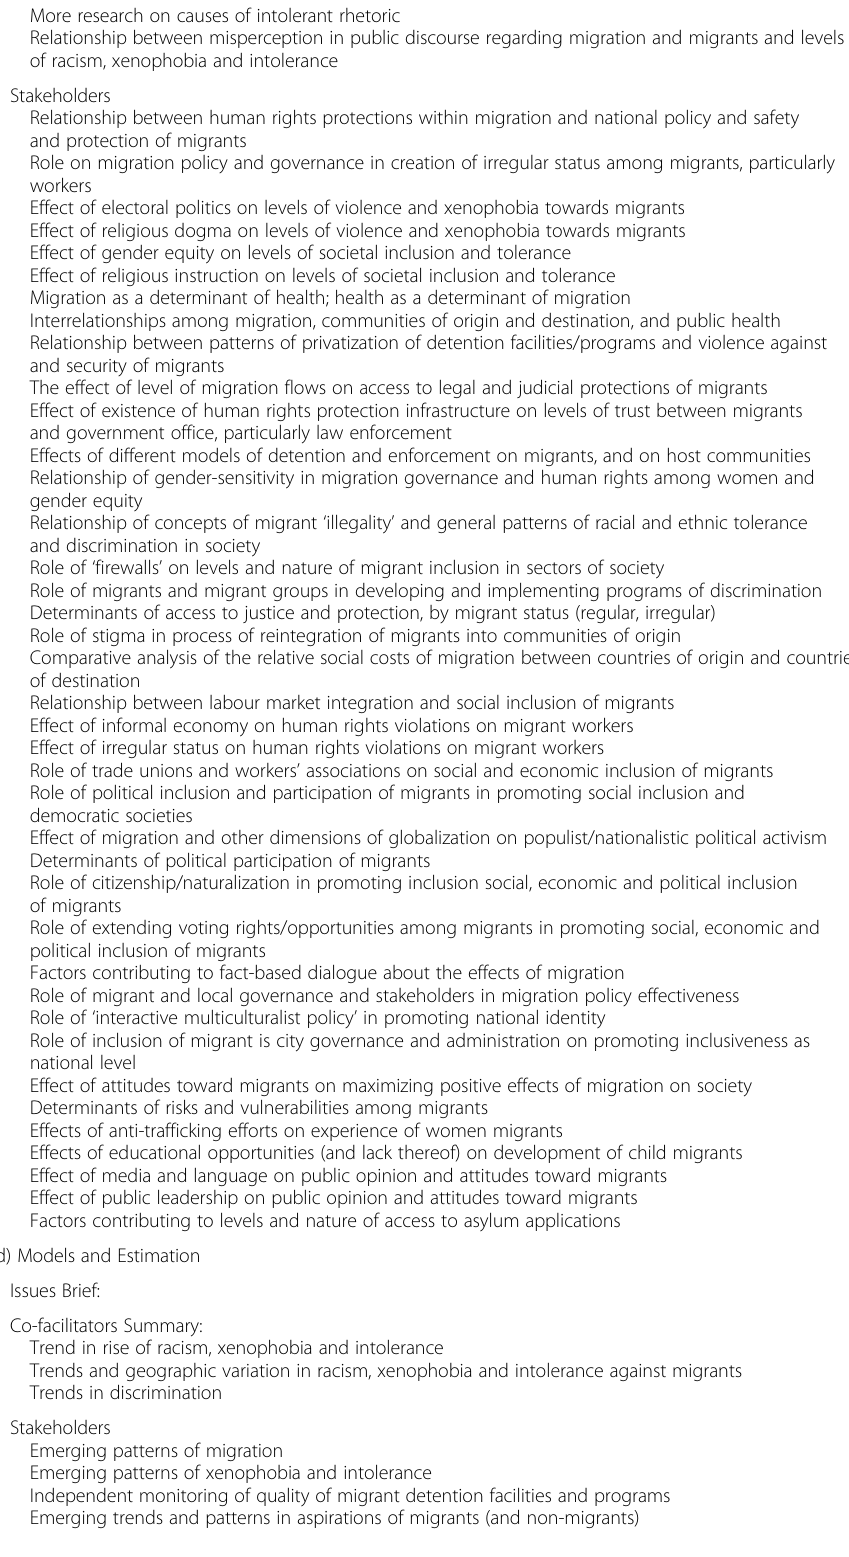
Table 1 Proposals for data and research: Thematic Session I Human rights of all migrants, social inclusion, cohesion and all forms of discrimination, including racism, xenophobia and intolerance